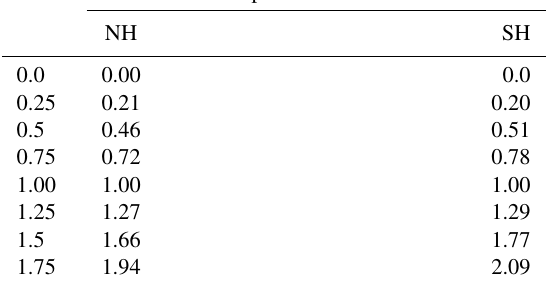
Table 1. Experiments and annual mean snow volume in the North- ern Hemisphere (NH) and Southern Hemisphere (SH) relative to the control experiment. F snow Annual mean snow volume in the experiments relative to the control ( F snow = 1 . 0) experiment in the preindustrial